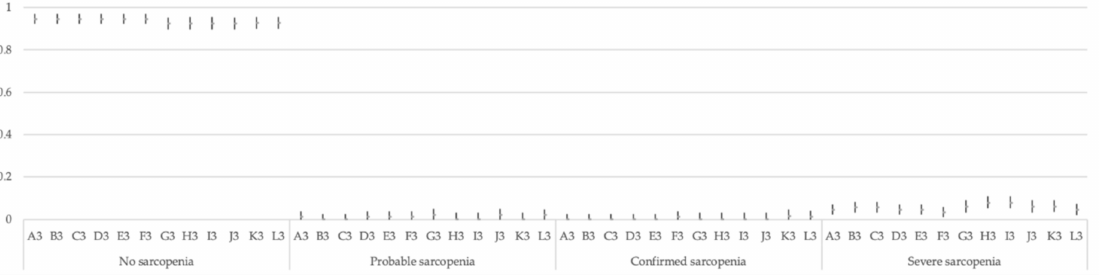
Figure 3. Multinomial 95% confidence intervals for the proportion of each category in the 12 options of Model 3.